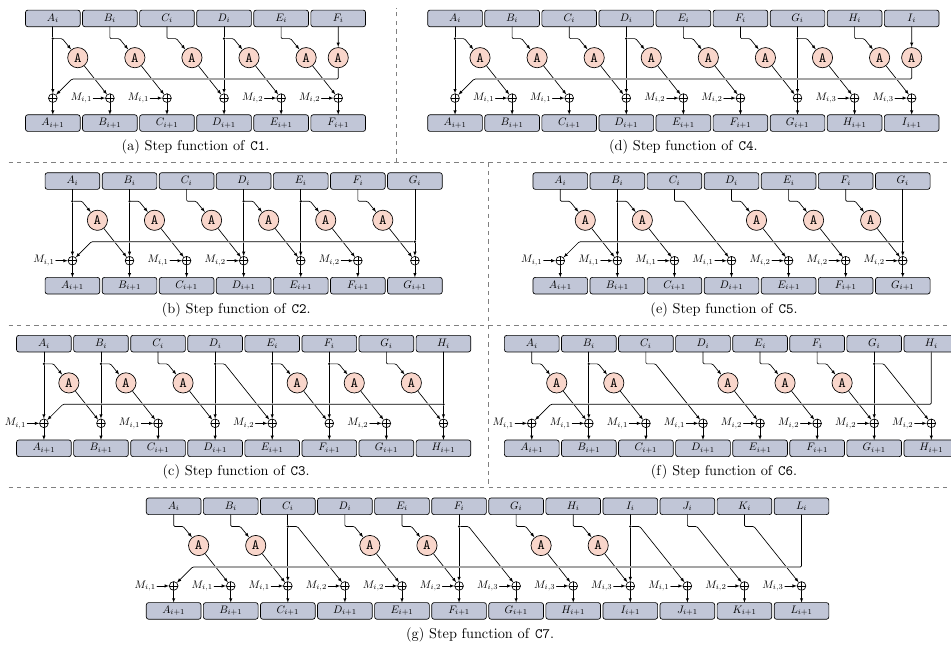
(cf. Figure 11(a) - Figure 11(g)) with excellent state size and efficiency trade-offs. The lower bounds for the number of active S-boxes for C1 - C7 using the MILP model are listed in Table 9, however the number of step functions necessary to attain the lower bound is not specified. As noted by the authors, the automatic search strategy they employ targets truncated differentials. There may not be a true differential characteristic that corresponds to the search outcomes. In other words, it is possible that the security of these structures was underestimated.